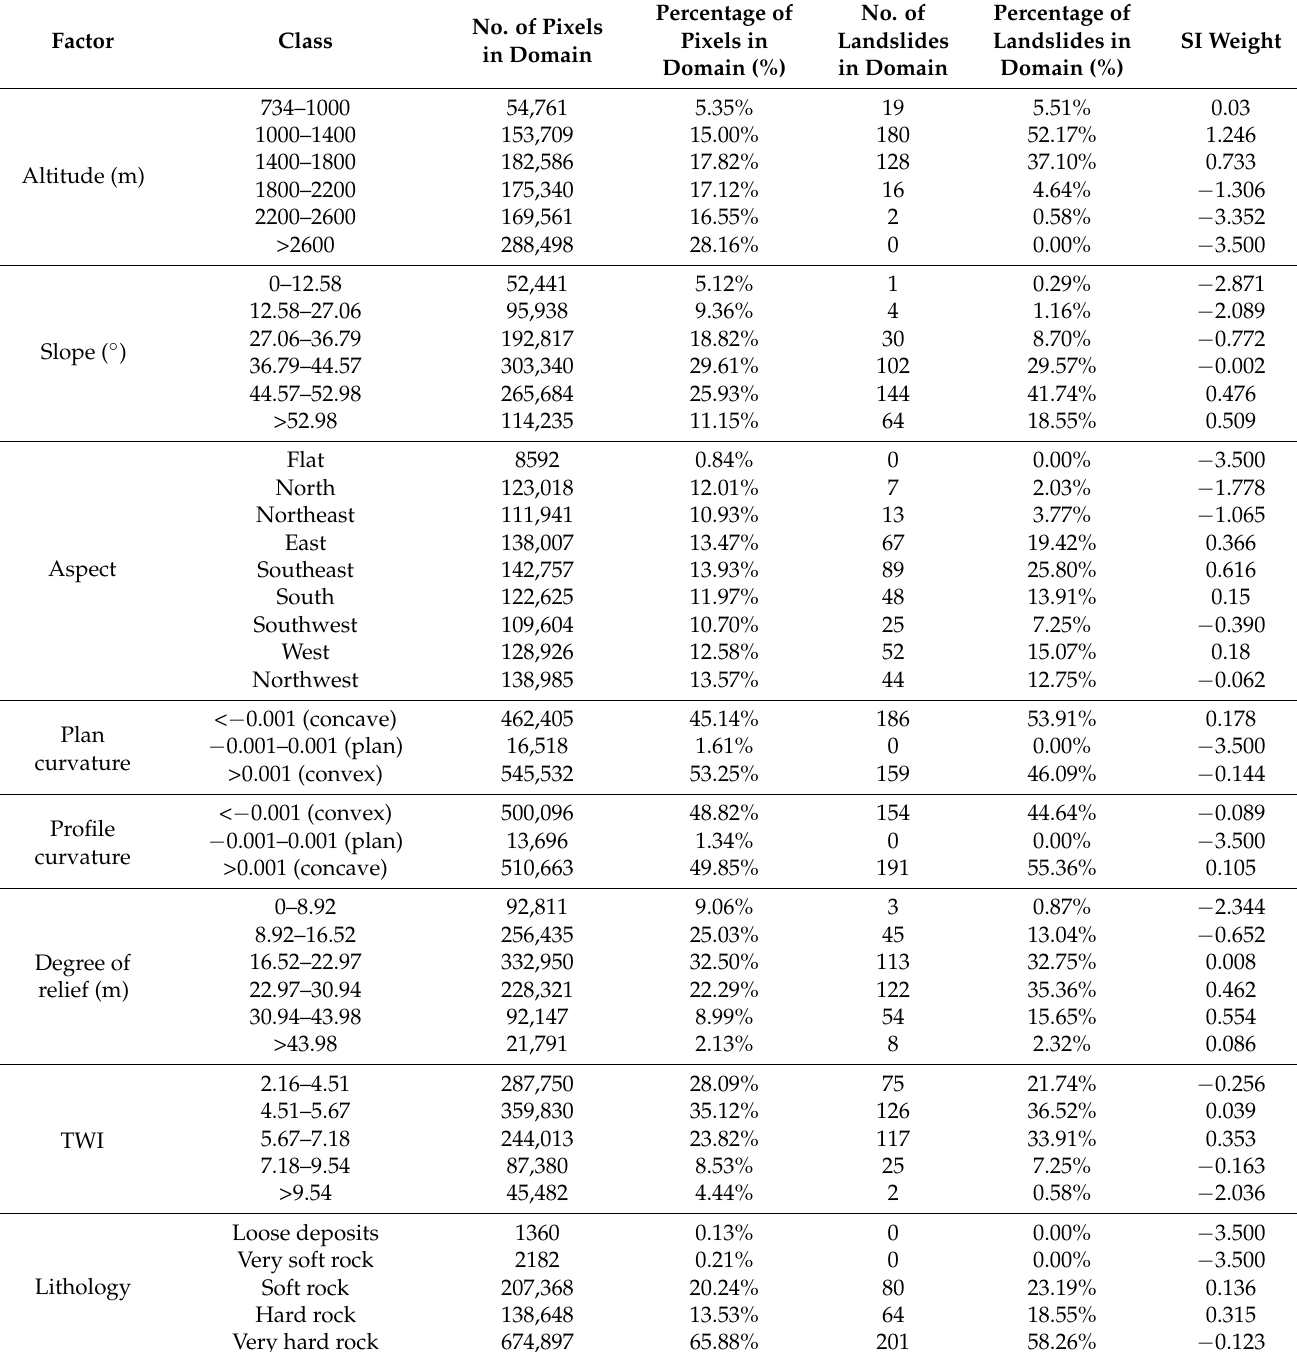
Table 2. The spatial relationship between landslides and influencing factors and the results of